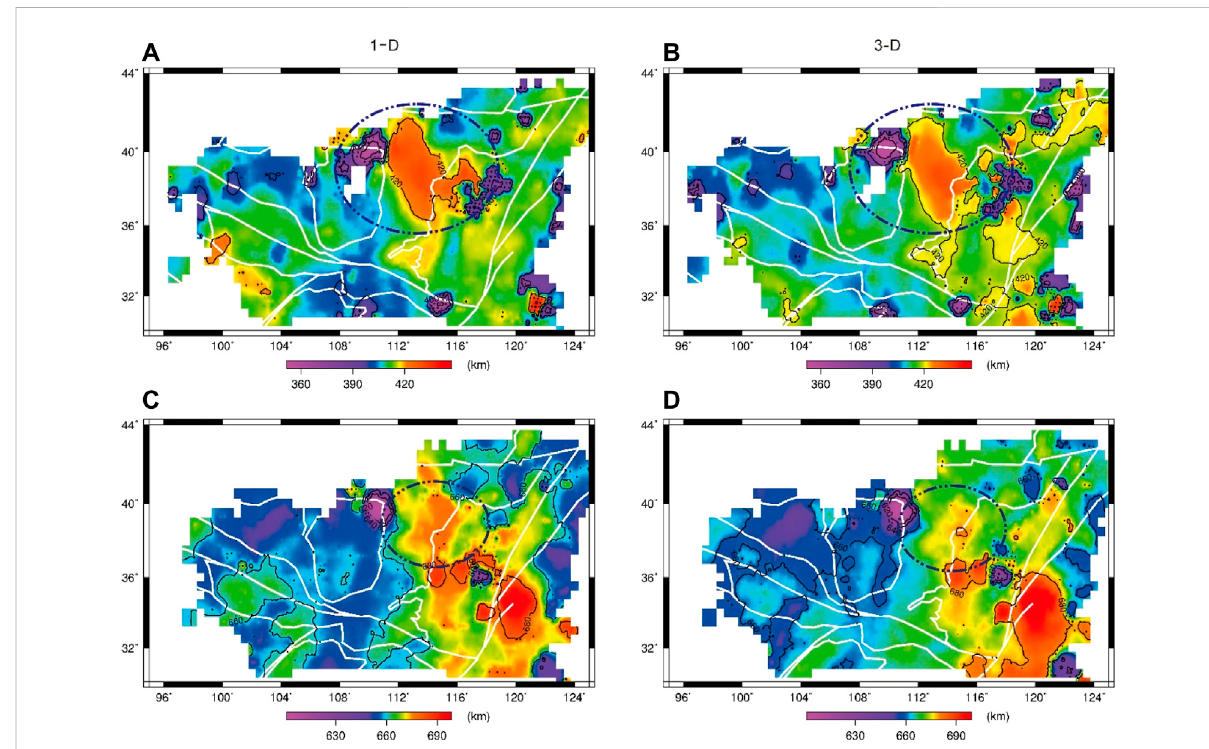
FIGURE 2 CCP stacking of receiver functions. Both the 410 km discontinuity (A,B) and the 660 km discontinuity (C,D) deepen by approximately 15 and 20 km (blue circles) and represent a vestige of an upwelling mantle plume in the NCC. Left panels: results corrected using the AK135 1-D velocity model (A,C) . Right panels: results corrected using the 3-D velocity model (B,D) inferred tomography (He,